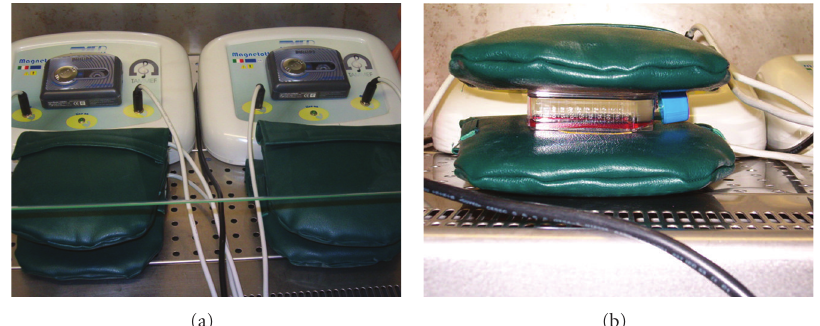
Figure 2: The apparatus used to generate the ELF EMFs and TAMMEFs (a). Cells were exposed to EMFs for 30 minutes (b) at room temperature.